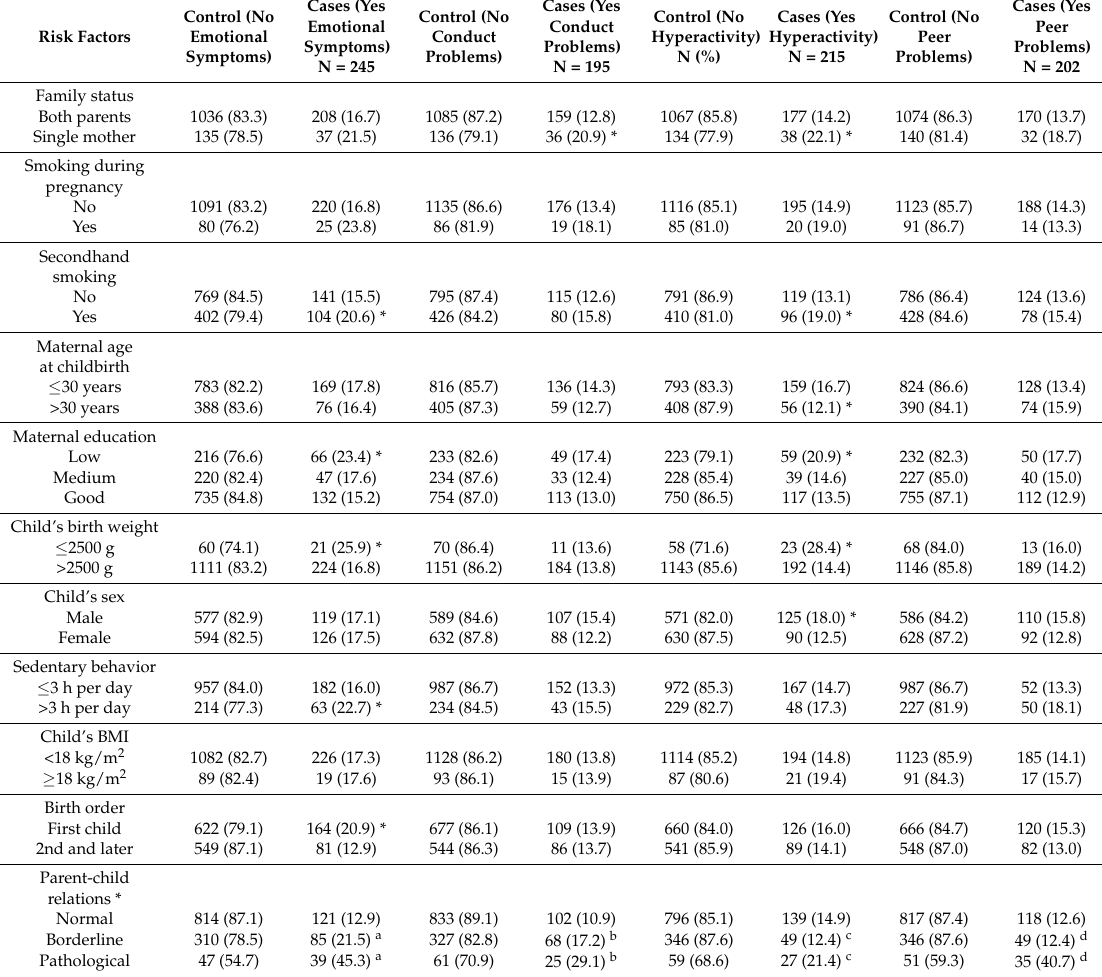
Table 1. Prevalence of mental health difficulties in preschool age